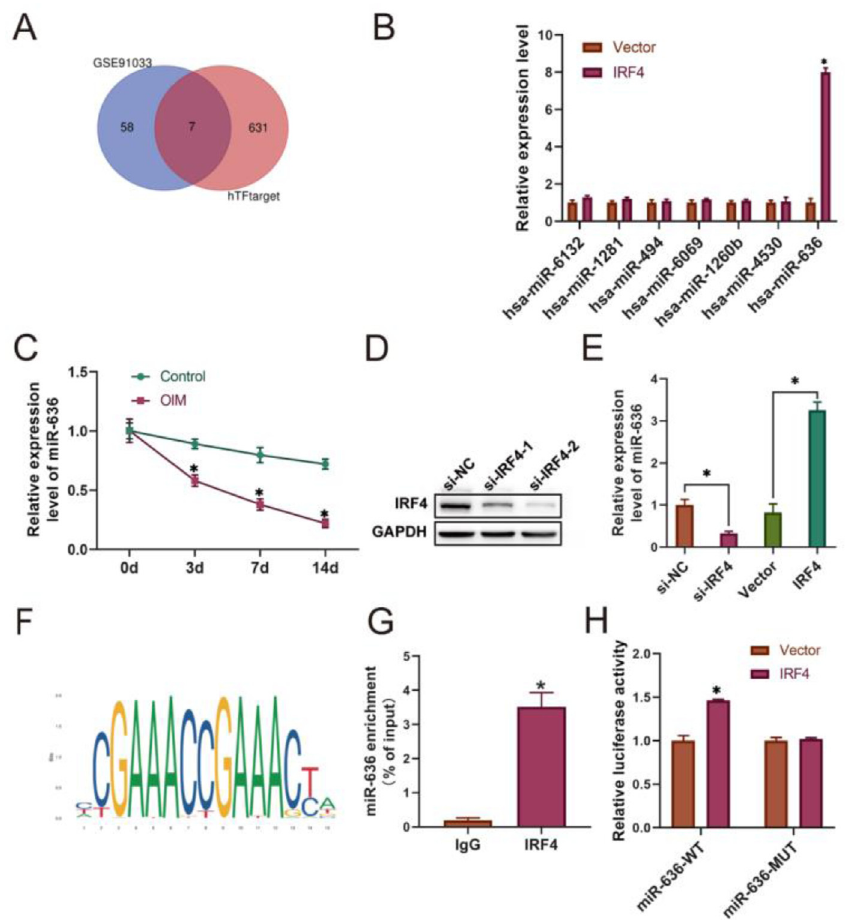
Fig. 3. IRF4 activates miR-636 in BM-MSCs. The hTFtarget database and GSE91033 dataset were used to identify the target genes of IRF4 (A), and q-PCR assay was utilized to detect the expression of inter- sected genes (B-C). IRF4-depletion and IRF4-overex- pression BM-MSCs were constructed, and Western blotting and q-PCR were respectively used to determine the transfection ef fi cacy (D) and miR-636 expression (E). The JASPAR database indicated the binding site (F), and the CHIP (G) and Dual Luciferase Reporter (H) assays con fi rmed the relationship between IRF4 and miR-636. * p < 0.05. Data represent at least three inde- pendent sets of